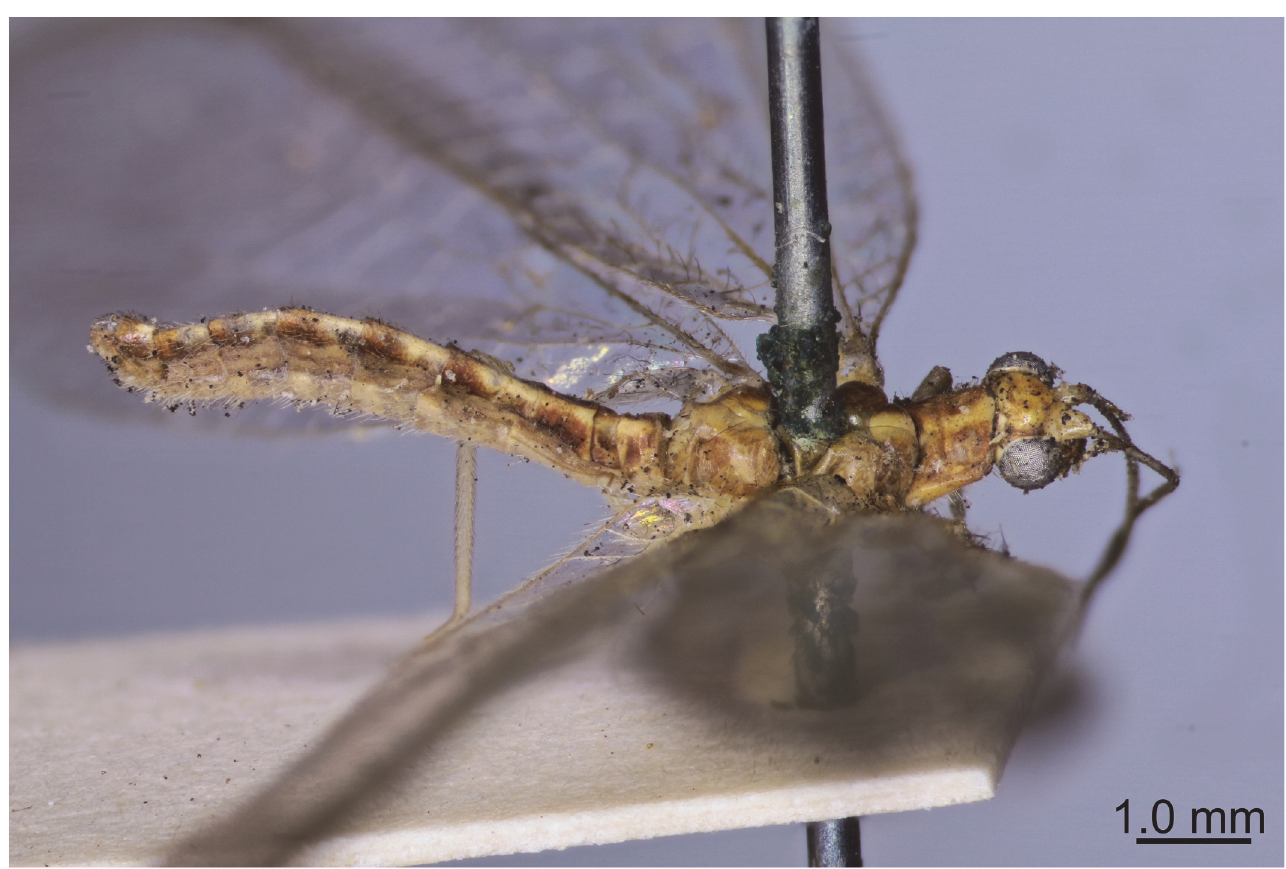
Fig 1. Lectotype of Chrysoperla carnea (Stephens). Mounted female specimen (voucher: BMNH(E) 1239048) is shown before dissection and abdomen